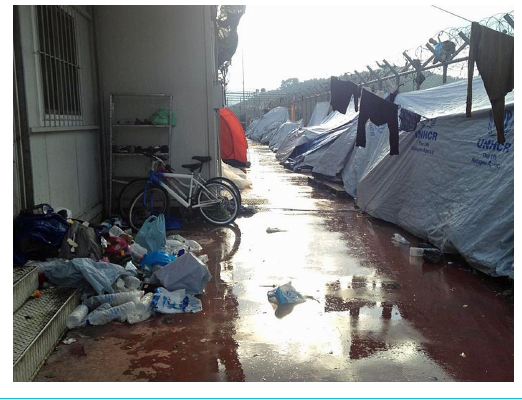
Figure 2: One of the streets in Moria camp. Photographer: Tricia Vannatter, health promoter.